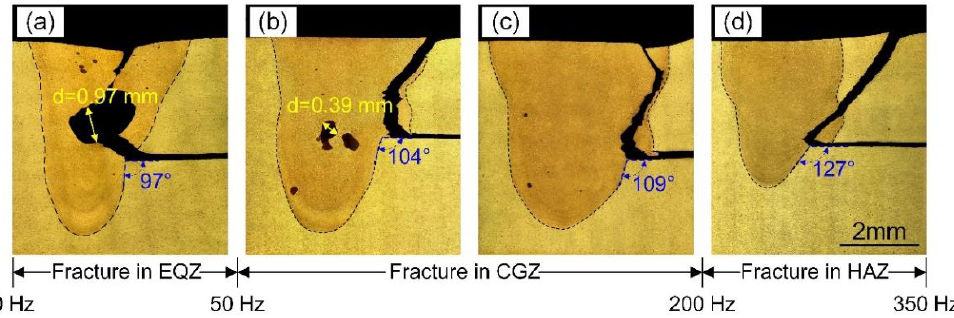
Figure 8. Fracture position of lock bottom welds, ( a ) f = 0 Hz, ( b ) f = 50 Hz, ( c ) f = 200 Hz, ( d ) f = 350 Hz.